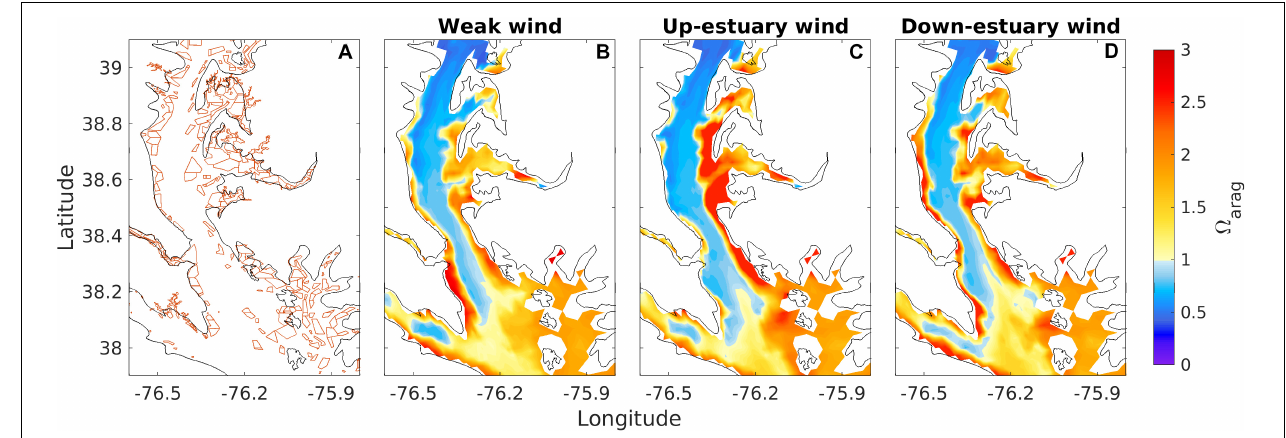
FIGURE 11 | Distribution of Maryland’s oyster bed in Chesapeake Bay (A) and bottom water aragonite saturation state (cid:127) arag in the oyster habitat under weak (B) , up-estuary (C) , and down-estuary (D) winds during August,